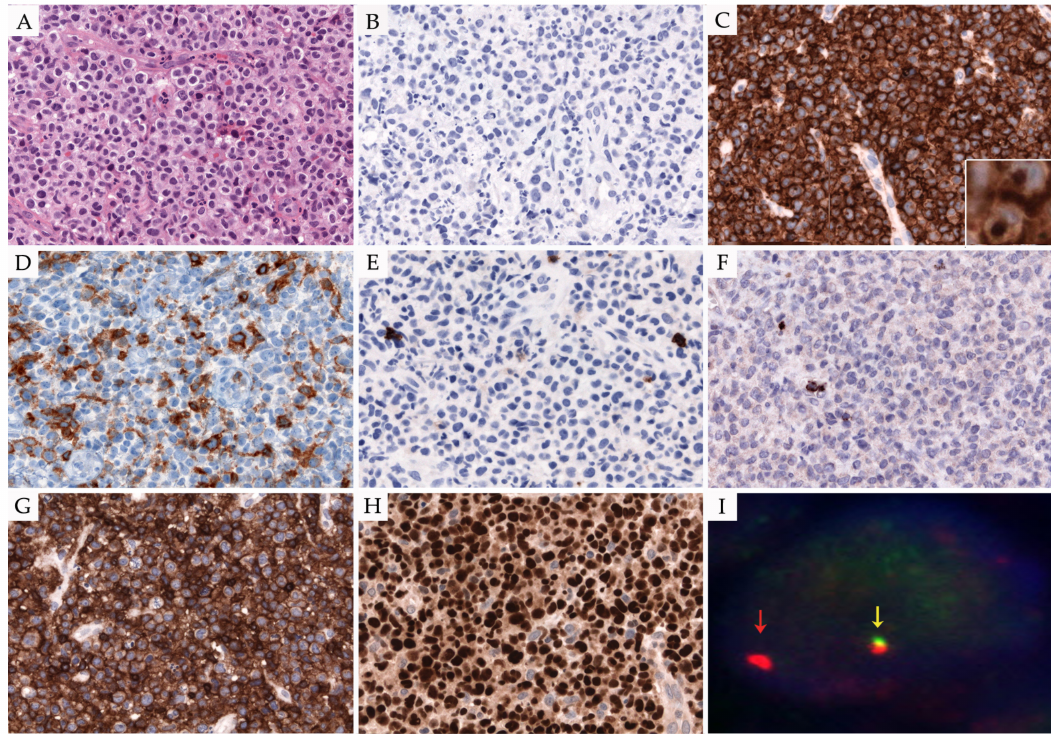
Figure 2. ALK − ALCL with DUSP-22 rearrangement. ( A ) Classic ALCL morphology is displayed; cells are relatively monomorphic (H&E stain, 400 × ); ( B ) Neoplastic cells lack ALK expression; ( C ) CD30 staining is strong and homogenous, showing a membranous and Golgi zone pattern (immunohistochemistry 400 × and insert 630 × ); ( D ) CD4; ( E ) CD8, and ( F ) TIA-1 are negative in the neoplastic cells, exhibiting a triple-negative phenotype; ( G ) Neoplastic cells stained positive for TCR alpha-beta (beta F1), demonstrating the T-cell origin; ( H ) IRF4/MUM1 reveals nuclear expression in all neoplastic cells (( B , D – H ); immunohistochemistry, 400 × ); ( I ) Fluorescent in situ hybridization (FISH) using a break-apart probe to the IRF4-DUSP22 locus on 6p25.3 shows one normal fusion signal (yellow arrow), one red signal (red arrow), and loss of one green signal, indicative of a IRF4-DUSP22 rearrangement. Abbreviations: H&E: hematoxylin and